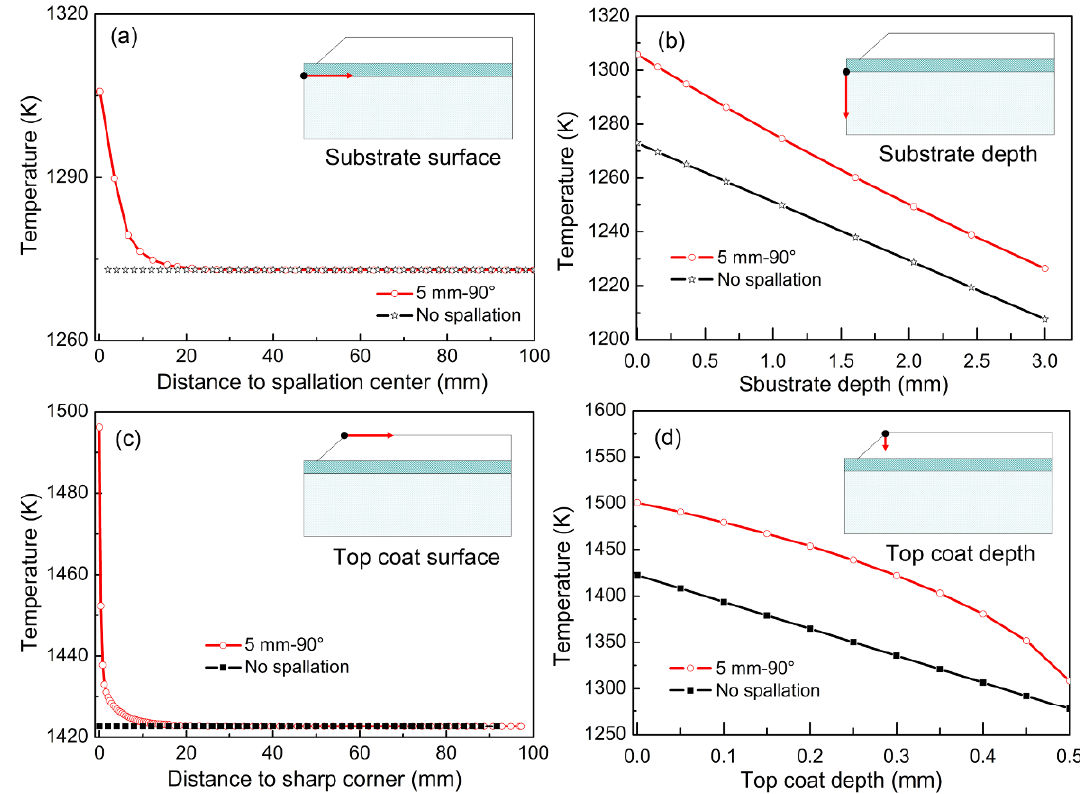
Fig. 5 Temperature distribution in TBCs: (a) along substrate surface direction; (b) along substrate depth direction; (c) along top-coat surface direction; and (d) along top-coat depth direction. The spallation diameter is 5 mm and the tilt angle is